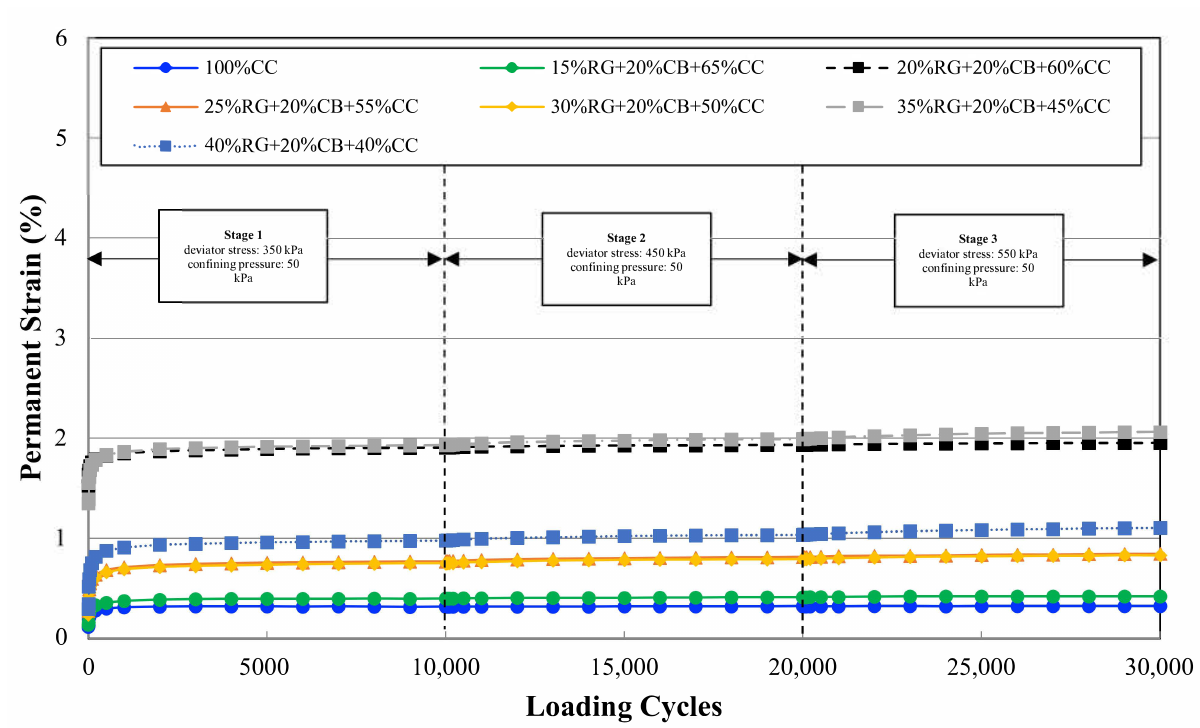
Figure 4. Permanent deformation of the nominated blends. There was a trend of higher permanent deformation with increasing RG content, but a couple of anomalies were noticed within the seven blends. Based on the RLT assessment, 15% RG performed the best among all the blends containing RG. Thus, the 15% RG + 20% CB + 65% CC blend was chosen for the WT test. Austroads [39] specifies a strain limit of 2% under permanent strain loading. All the samples experienced lower values than this limit, except for 35% RG + 20% CB + 45% CC at stage 3 of loading. Among those tested, the blend containing 15% RG + 20% CB + 65% CC had a similar rate of permanent deformation to 100% CC after the first 3000 cycles at each loading stage. Therefore, this blend was chosen for further assessment under the WT loading condition. A WT test was conducted on the 15% RG + 20% CB + 65% CC sample in a temperature- controlled chamber with a set temperature of 25 ◦ C. The sample size was 500 mm (W) × 700 mm (L) × 300 mm (D). The sample was compacted inside the mold at 80% OMC in six layers using a segmented roller compactor with a maximum load capacity of 30 kN, to reach 98% MDD. Figure 5 shows the different stages of WT sample preparation. The sample was dried back to 70% OMC for the WT test. The sample was sealed with epoxy before the start of the test. The sample was mounted to the temperature control chamber (25 ◦ C) for WT testing. The rutting was recorded using a laser at specific sections (five) during the test to determine the transversal deformation. Figure 6a shows the WT test setup and Figure 6b shows the laser rut sections and measurement area. The WT test was carried out for 40,000 cycles and the mean deformation was recorded after each loading cycle, unless the sample deformed more than 18 mm during the test and failed to meet standards according to Austroads AGP-T054